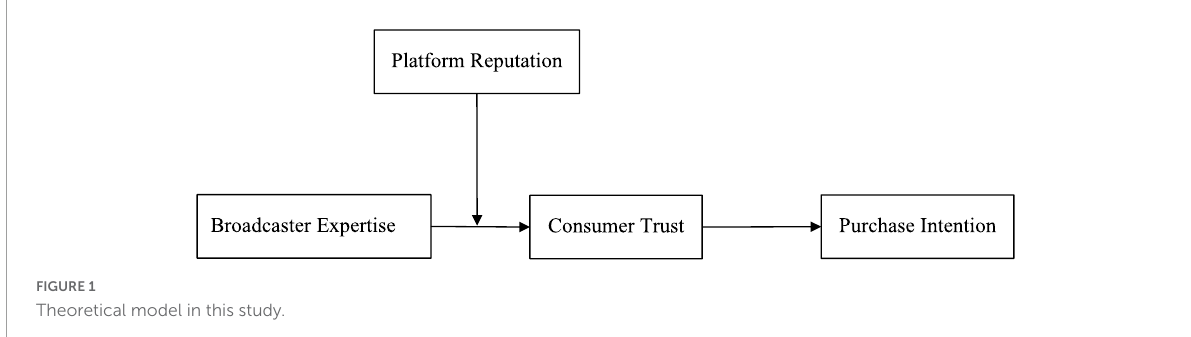
FIGURE1 Theoretical model in this study.